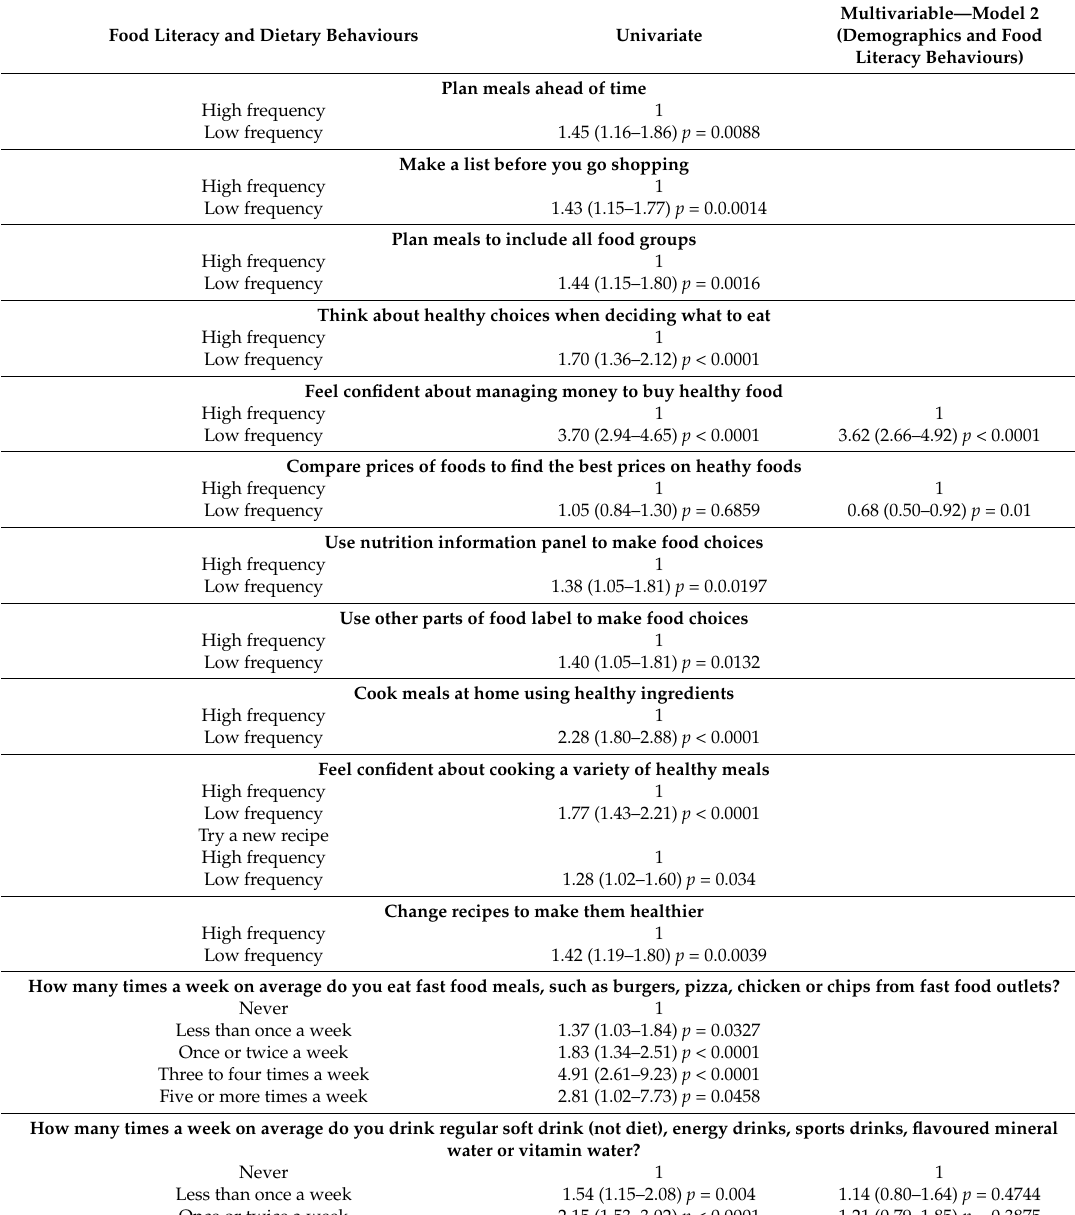
Table 6. Food literacy and dietary behaviour variables and its association with food insecurity. Food Literacy and Dietary